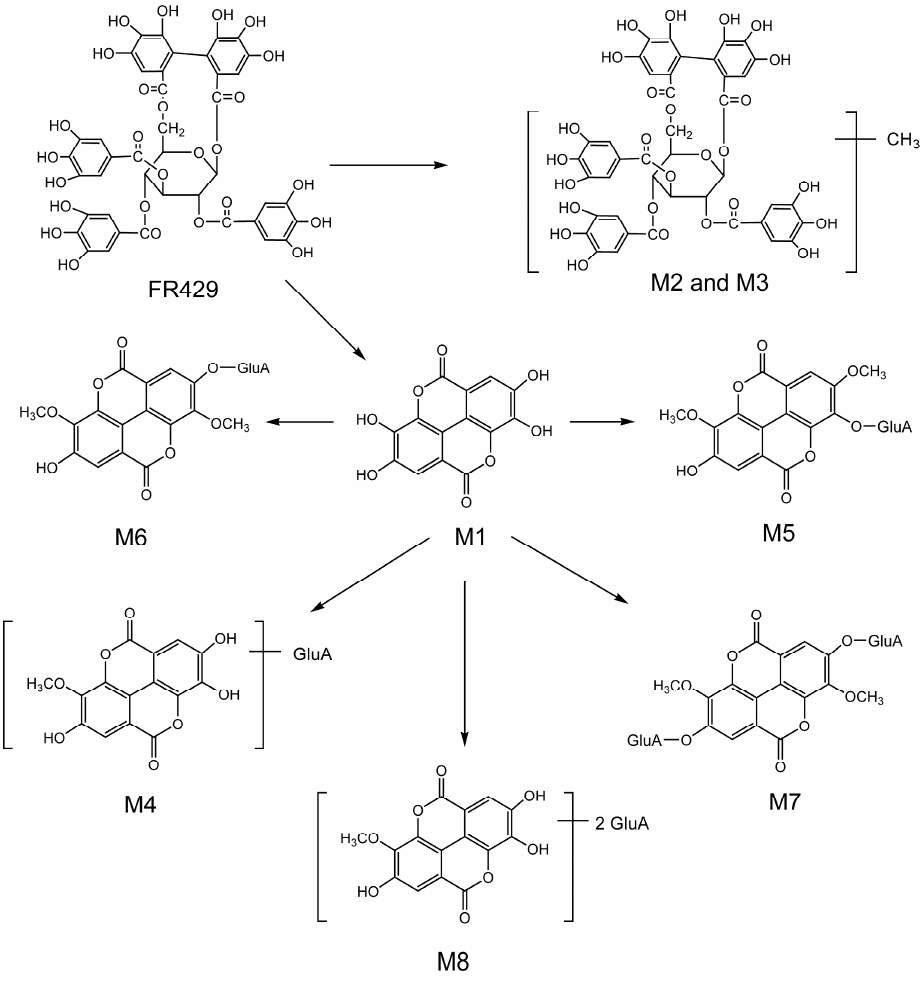
Figure 3. Proposed in vivo metabolic pathways of FR429 in rats .